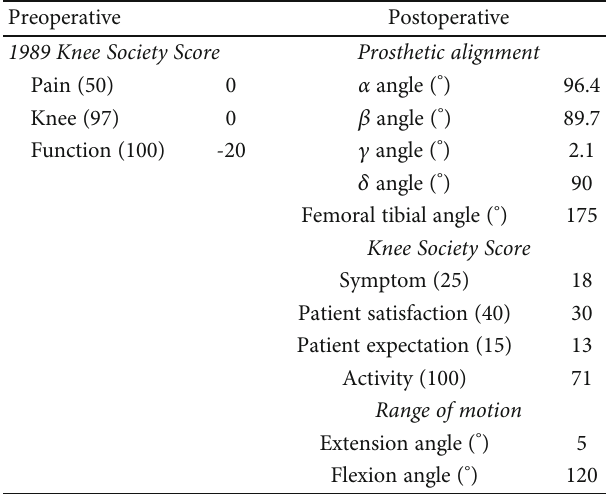
Table 1: Pre- and postoperative clinical data (90-year-old female,